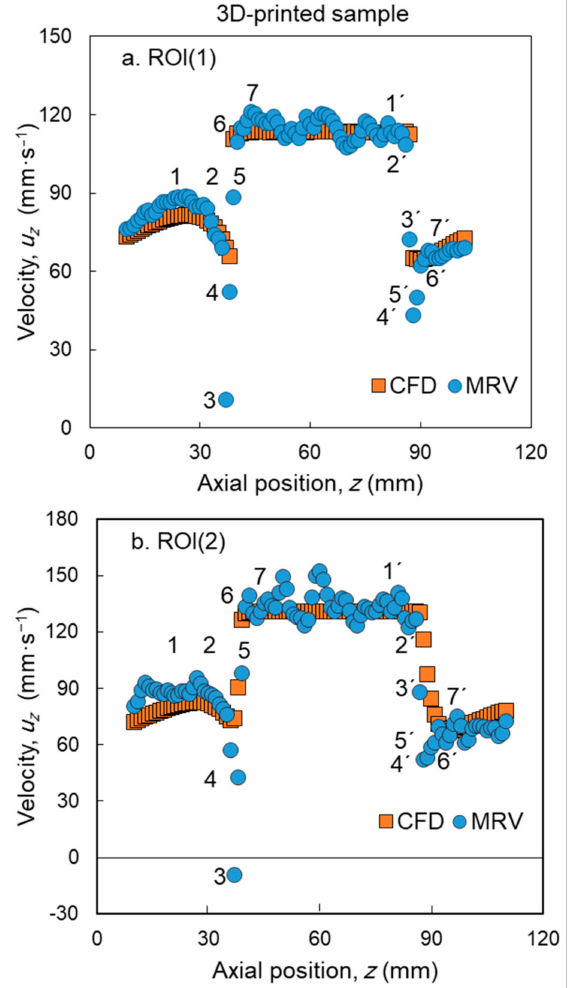
Figure 9. Comparison of the radially averaged axial velocity component obtained by CFD and MRV in ( a ) ROI(1) and ( b ) ROI(2). The axial position on the z -axis covers the entrance (1–7), inside (7–1 (cid:48) ), and exit region (1 (cid:48) –7 (cid:48) ) of the 3D-printed